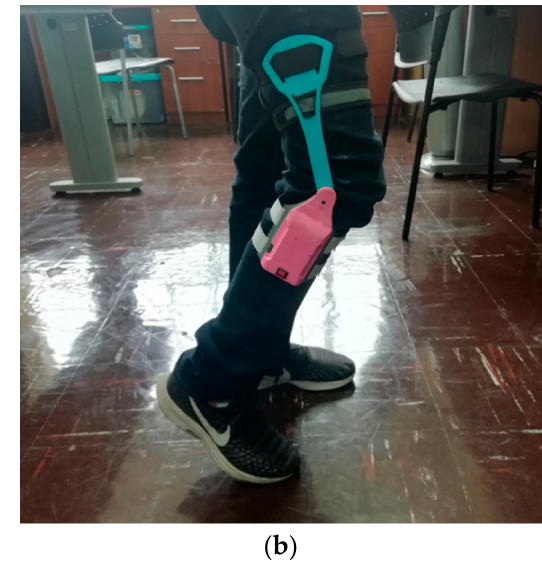
Figure 2. ( a ) 3D model of a person using the wearable; ( b ) a user wearing the wearable goniometer.